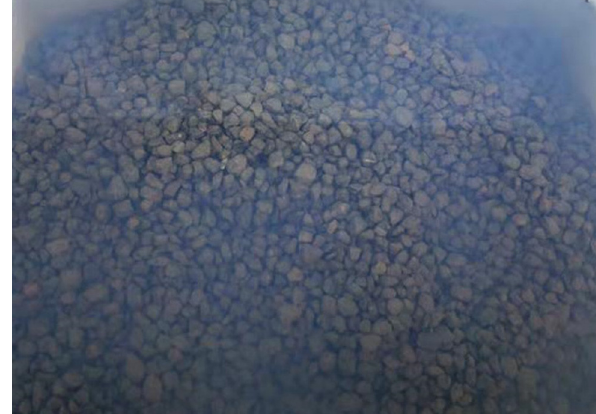
Figure 1: Soaking of